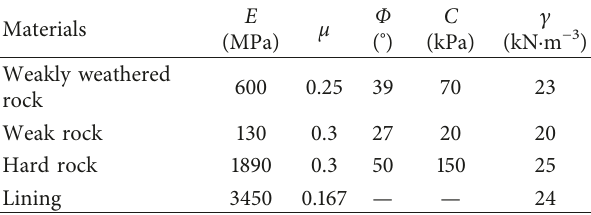
Figure 3: Measuring Table 1: Physical and mechanical parameters of the surrounding rock and lining model.